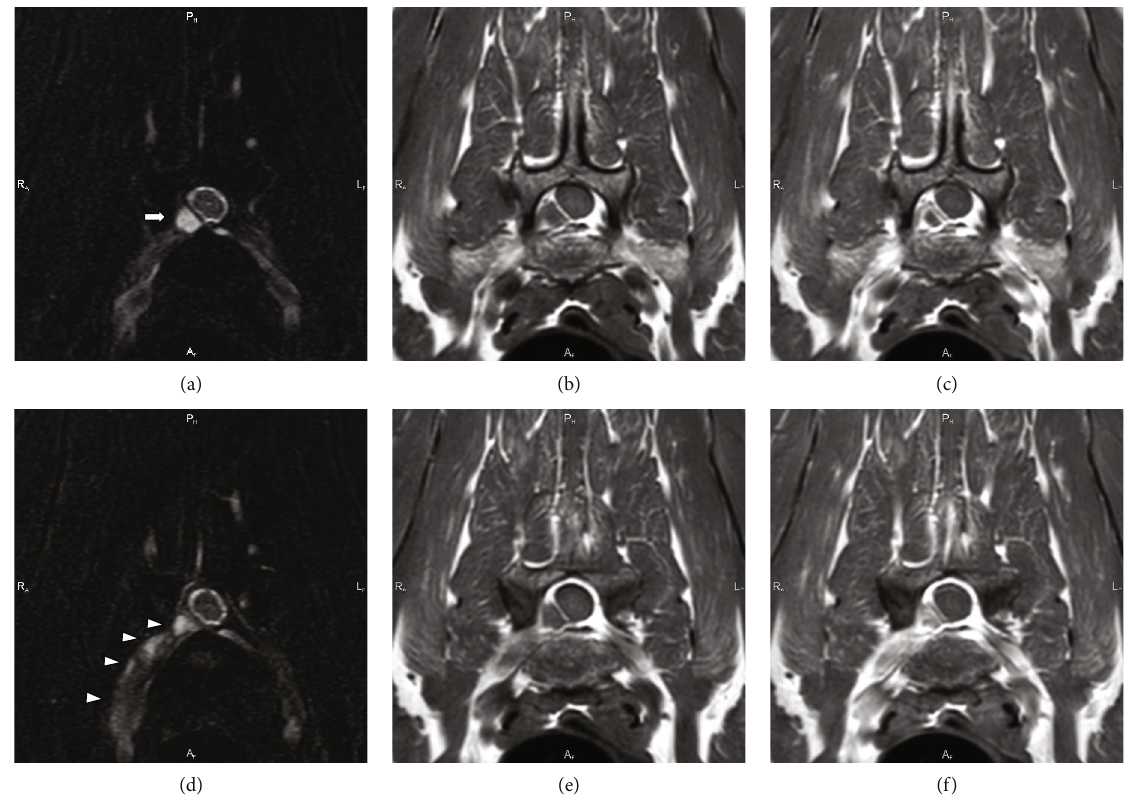
Figure 1: Transverse view of the cervical spine at the level of C8 at the level of nonenhancing material (white arrow), (a) T2 FS Dixon, (b) T1 precontrast, (c) T1 postcontrast, and at the nerve root level (white arrowhead), (d) T2 FS Dixon, (e) T1 precontrast, and (f) T1 postcontrast. There is moderate enlargement, heterogeneity, and contrast enhancement along the right ventral C8 nerve.